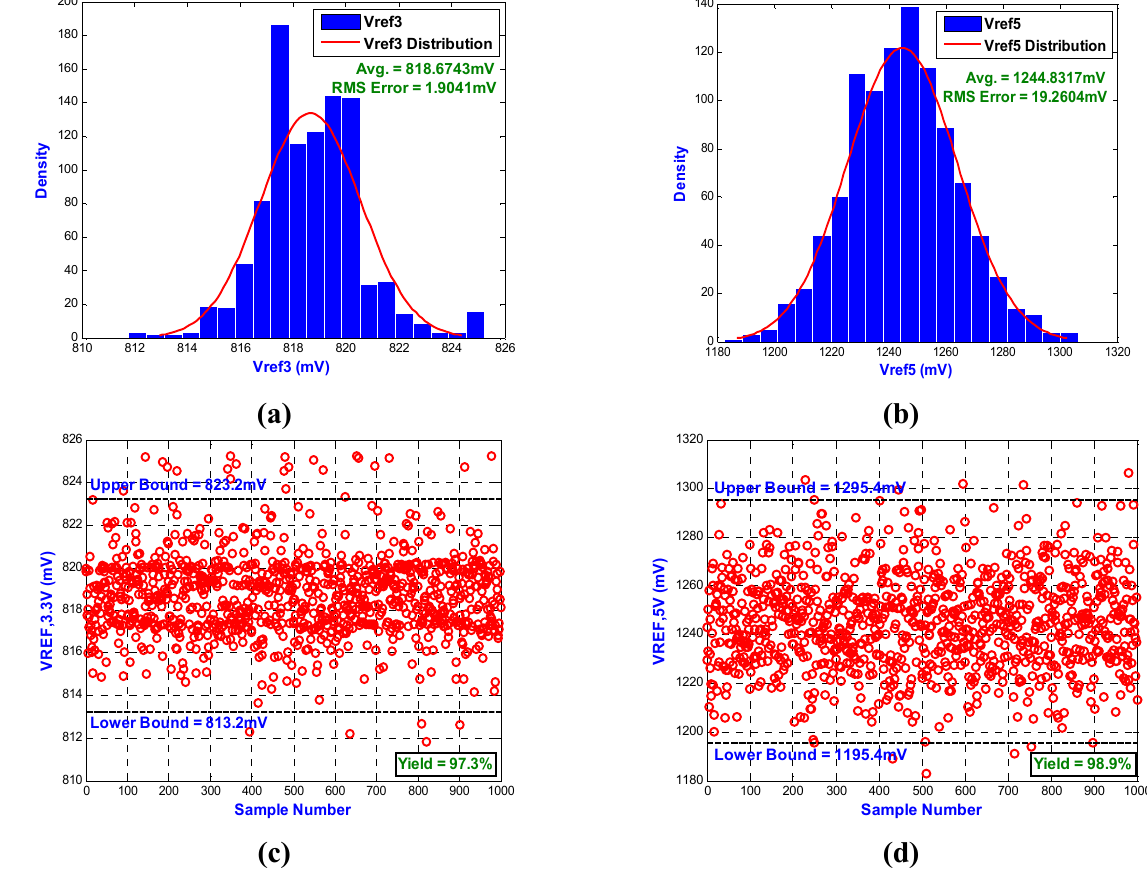
Figure 7. Block diagram of the successive approximation